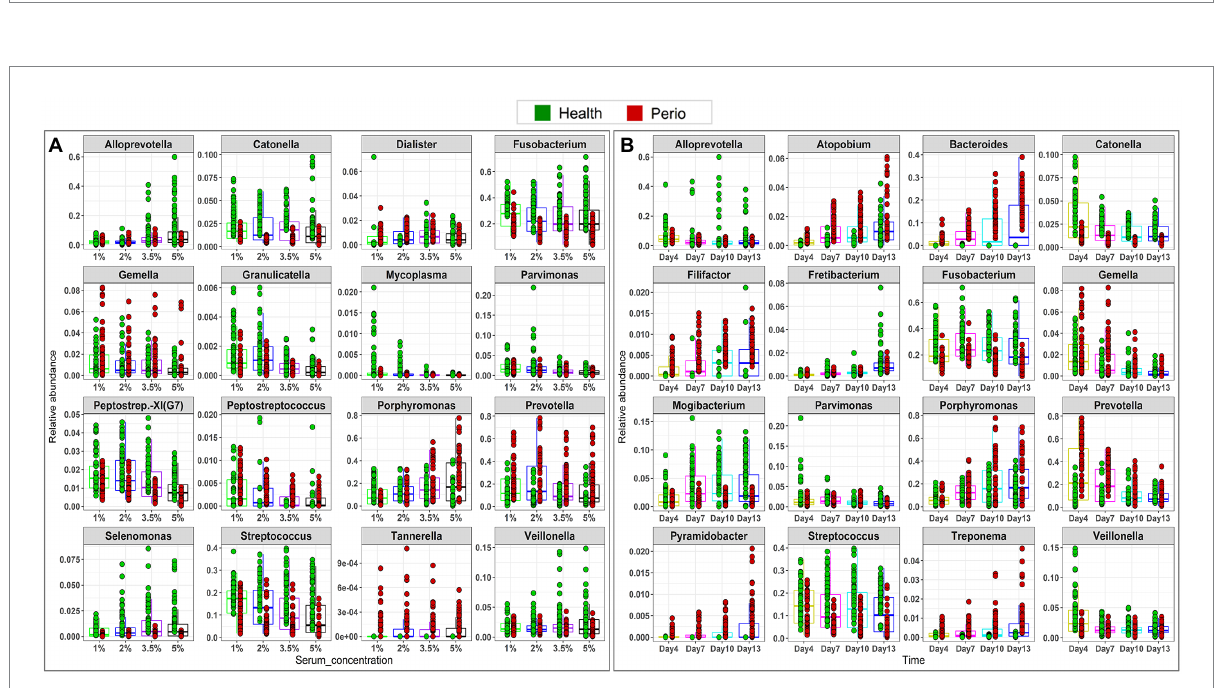
FIGURE 5 Selected differentially abundant genera by serum concentration and incubation period. Centered log-ratio (CLR) transformed data were analyzed with MaAsLin2 including health status, biological replicate, medium, shaking, and incubation time as fixed effects and technical replicates as random effects. Relative abundances are shown for 16 genera that significantly differed (FDR value < 0.1) by serum concentration (A) and 16 genera that differed by incubation period (B) . Plots were produced with